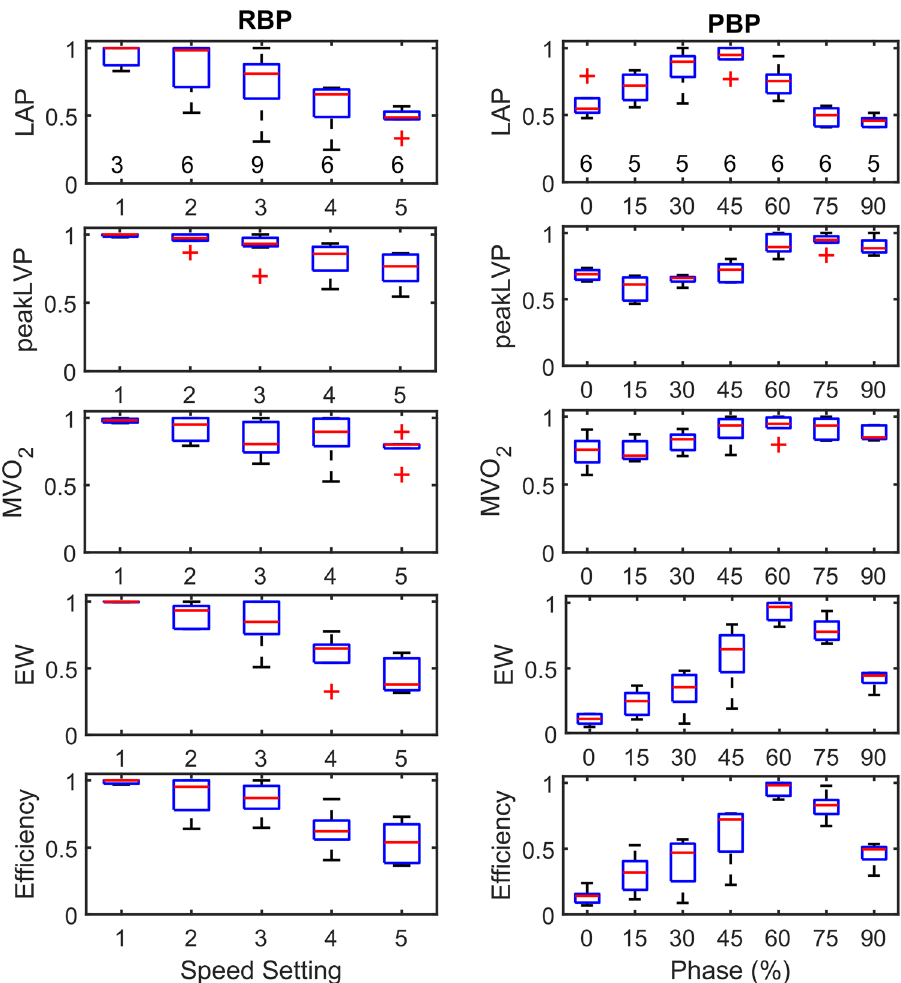
Figure 3. Box plots of hemodynamic parameters normalized by the maximum value of each experiment for the RBP and PBP. The number of included measurements in each of the box is presented in the upper